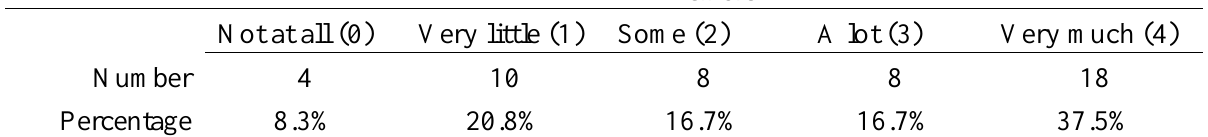
Table 4. Distribution of Parents’ Answers to the Global Question: How much is your child’s overall wellbeing affected by the condition of his/her teeth, lips, jaws, or